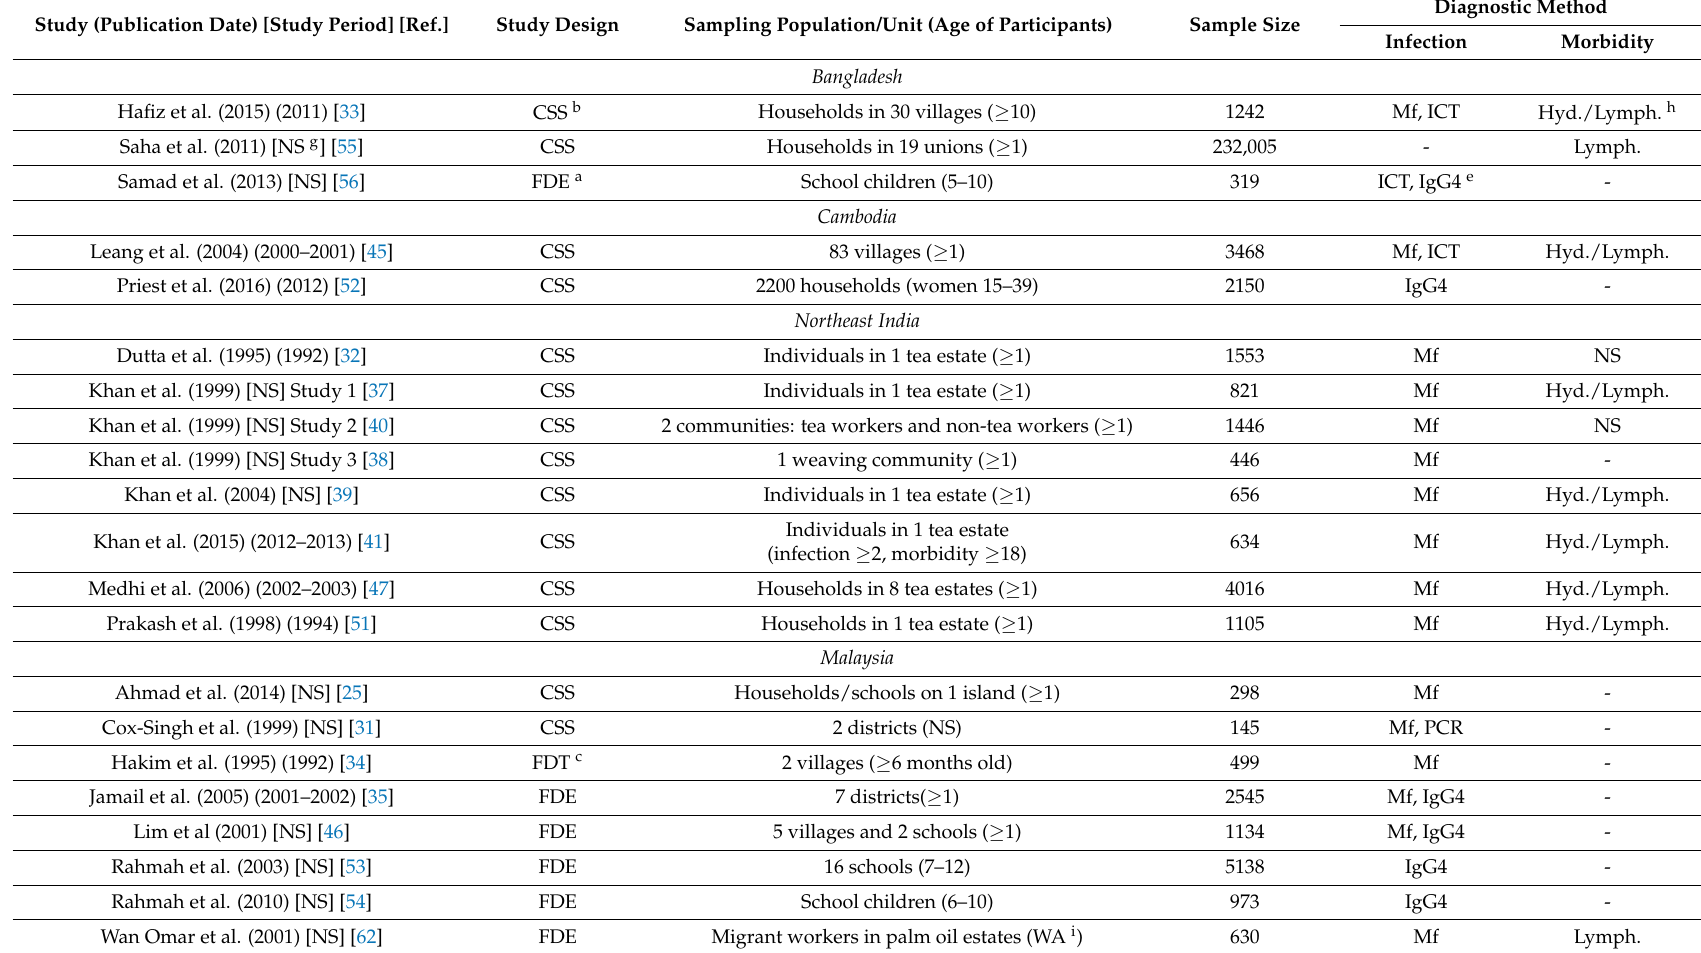
Table 1. Included peer-reviewed journal